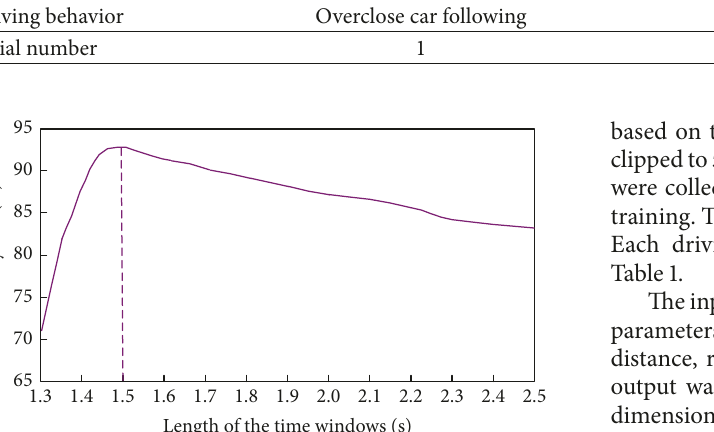
Table 1: Serial number for each driving behavior type.